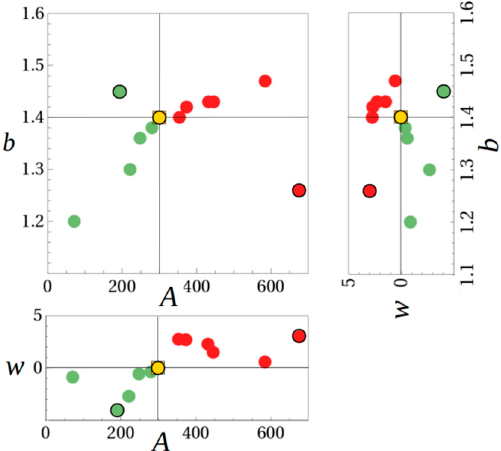
Figure 12. Circles: { A , b , w } data from Athalassa disdrometer-ECMWF data; Circles with black border: predictions based on theoretical DSD of Equation (22); Yellow square: NWS standard A-b ; Yellow circle with black border: A - b for w = 0 based on Equation (22).